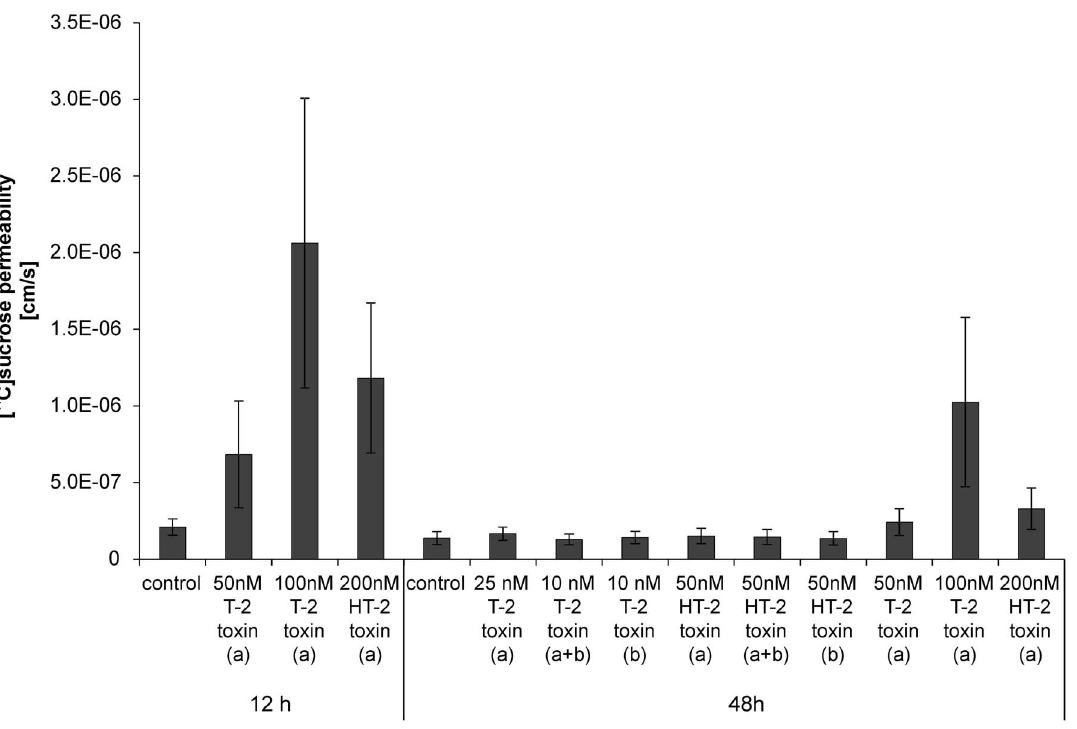
Figure 4. Barrier integrity after toxin incubation as determined by [ 14 C]sucrose permeation. Permeation of [ 14 C]sucrose was used as an additional indicator for barrier integrity after incubation of different concentrations of T-2 and HT-2 toxin for 12 h and 48 h from the apical side (a), the basolateral side (b) or from both sides (a + b); all: mean 6 SEM; n=3.